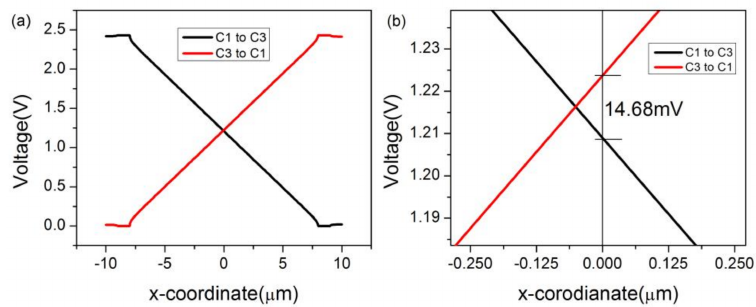
Figure 3. ( a ) Voltage along the top edge of the three-contact vertical Hall device without C2 and ( b ) distribution of voltage around the middle of the device under different biases.